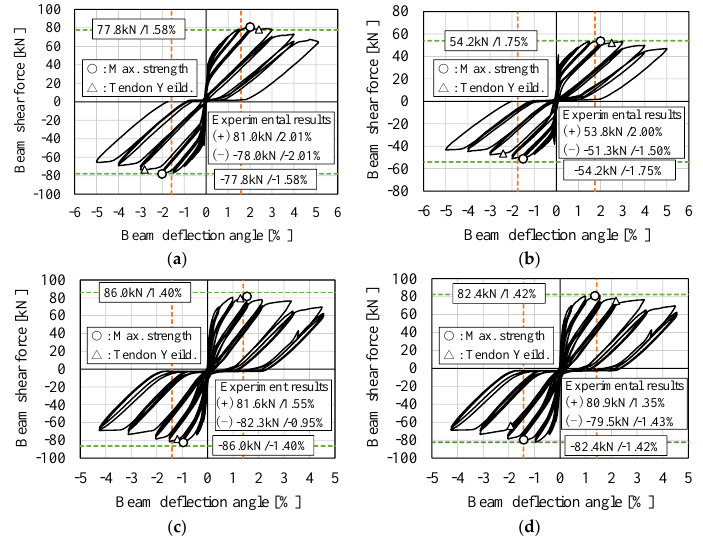
Figure 13. Load − deflection curves of PC beams and experiment − calculation comparisons: ( a ) PCX01; ( b ) PCX02; ( c ) PCJ05; ( d ) PCJ06. The dashed lines represents the evaluated values of P b , u and R b , u .